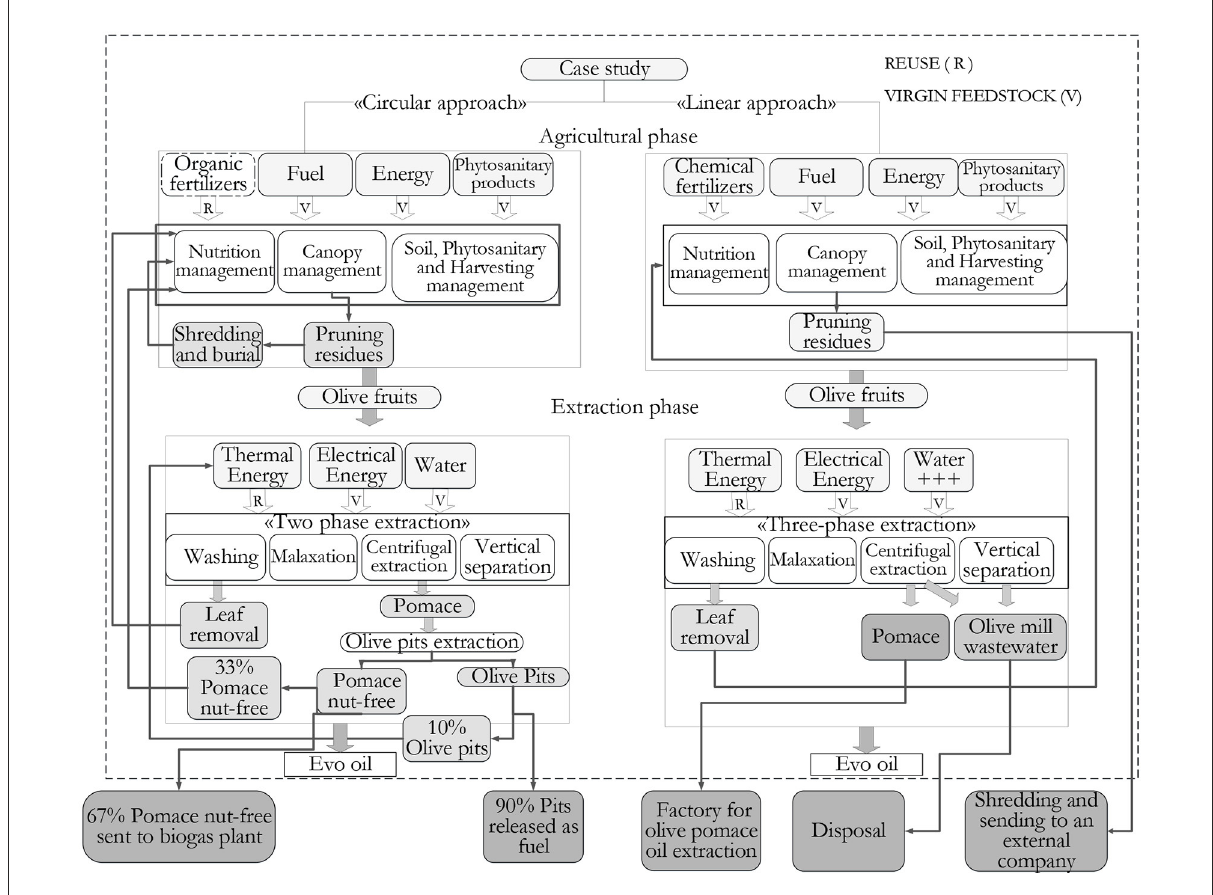
FIGURE1 Circular and linear scenarios under assessment (Source: Authors’